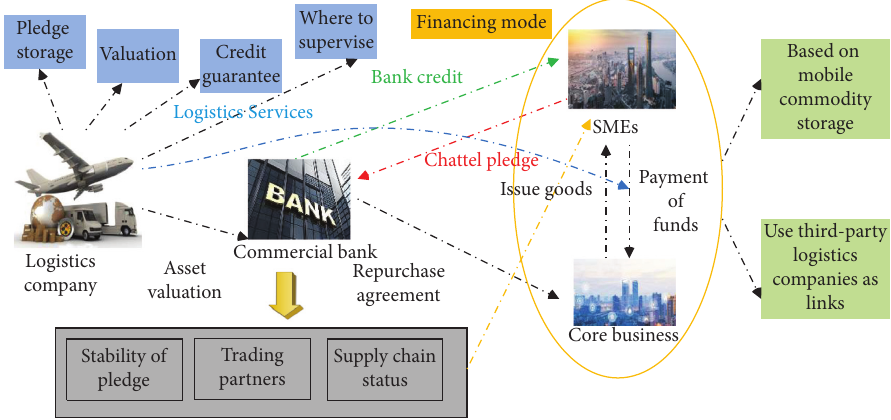
Figure 1: Schematic diagram of financial services industry financing and warehouse